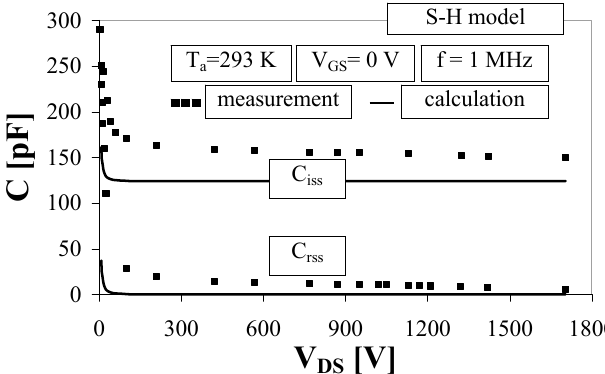
Figure 5. Measured and calculated (S–H model ) C iss (V DS ) and C rss (V DS ) characteristics of the JFET.